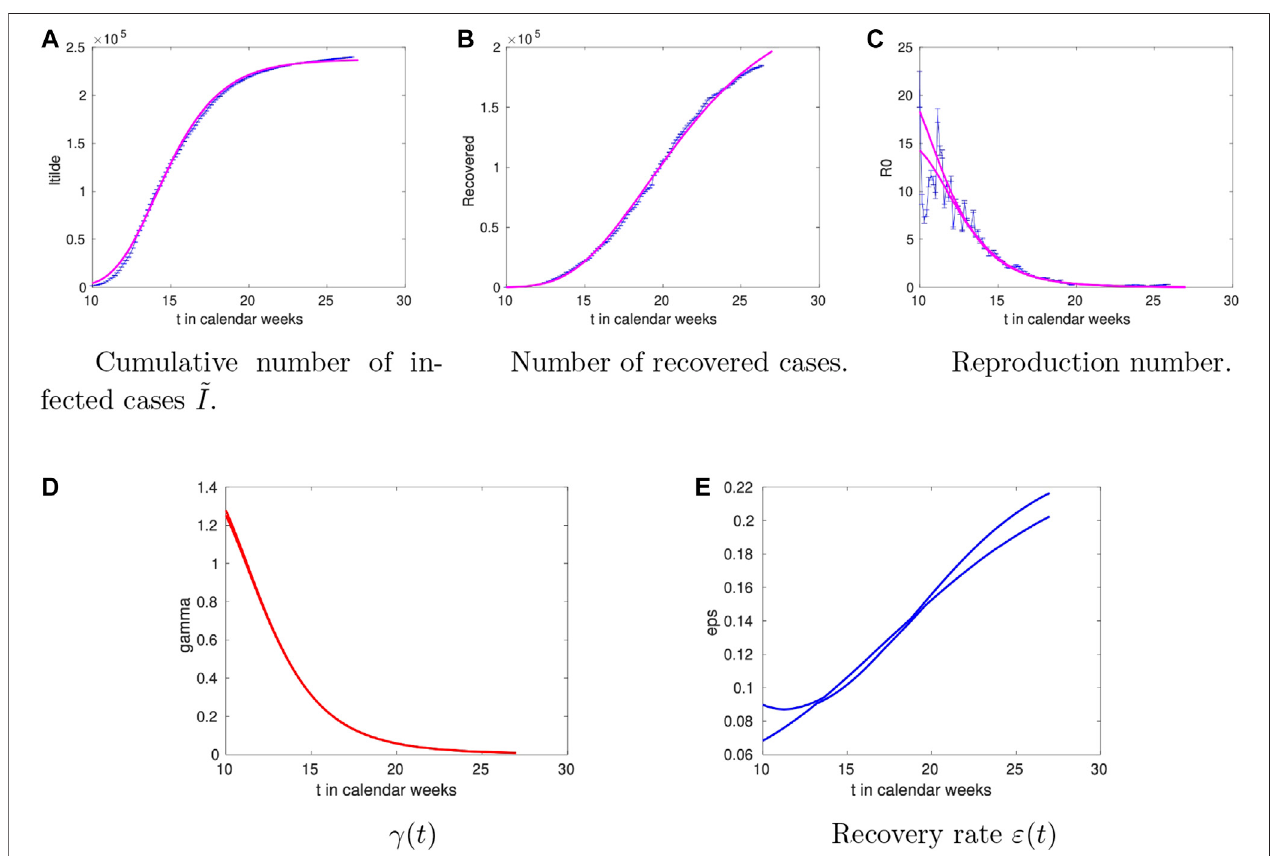
FIGURE 4 | Time dependence of ~ I ( t ) , R ( t ) , R 0 ( t ) , c ( t ) and ε ( t ) within the eRG SIR model optimised to describe the Italian data for COVID-19. Solid lines are the model (shown as a 95% con fi dence level band for the predictions) and the dots with error-bars are the data.